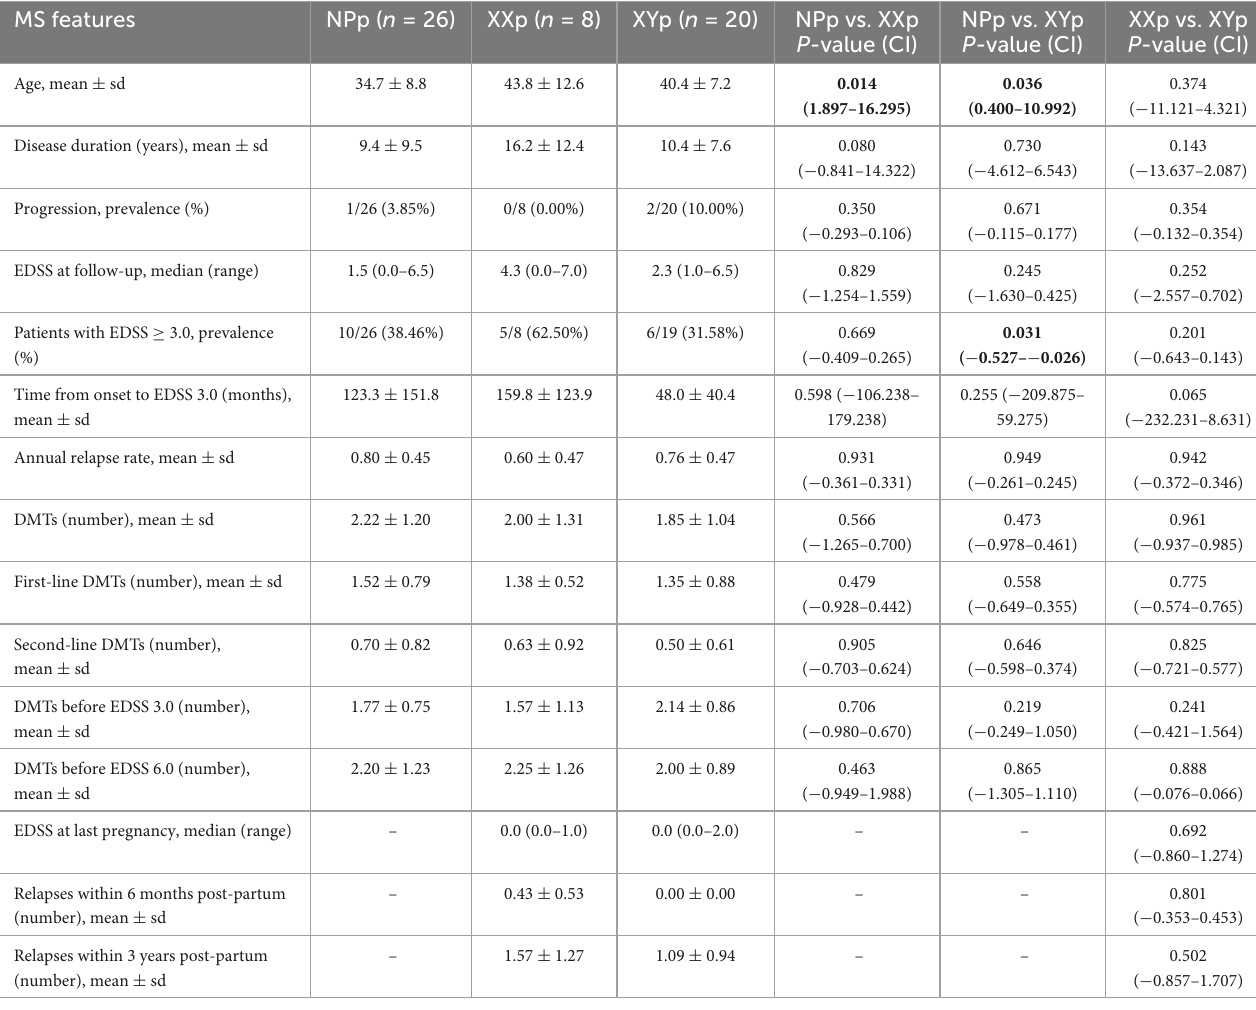
TABLE 4 Comparison of MS features at last clinical follow-up.